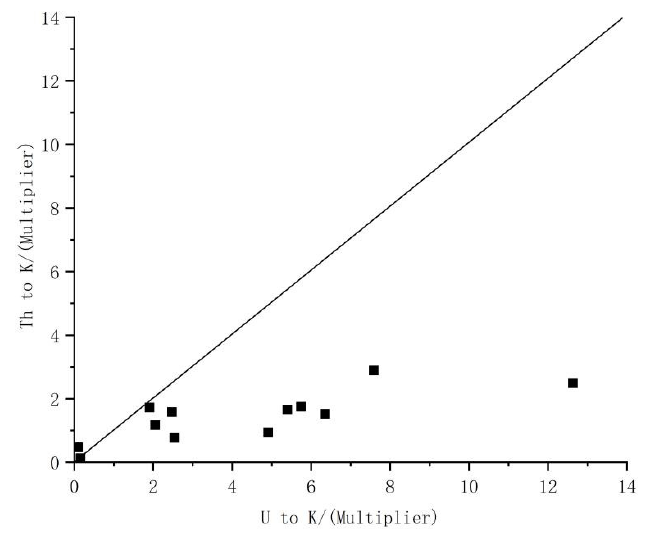
Figure 11. Contribution of heat from U, Th and K.